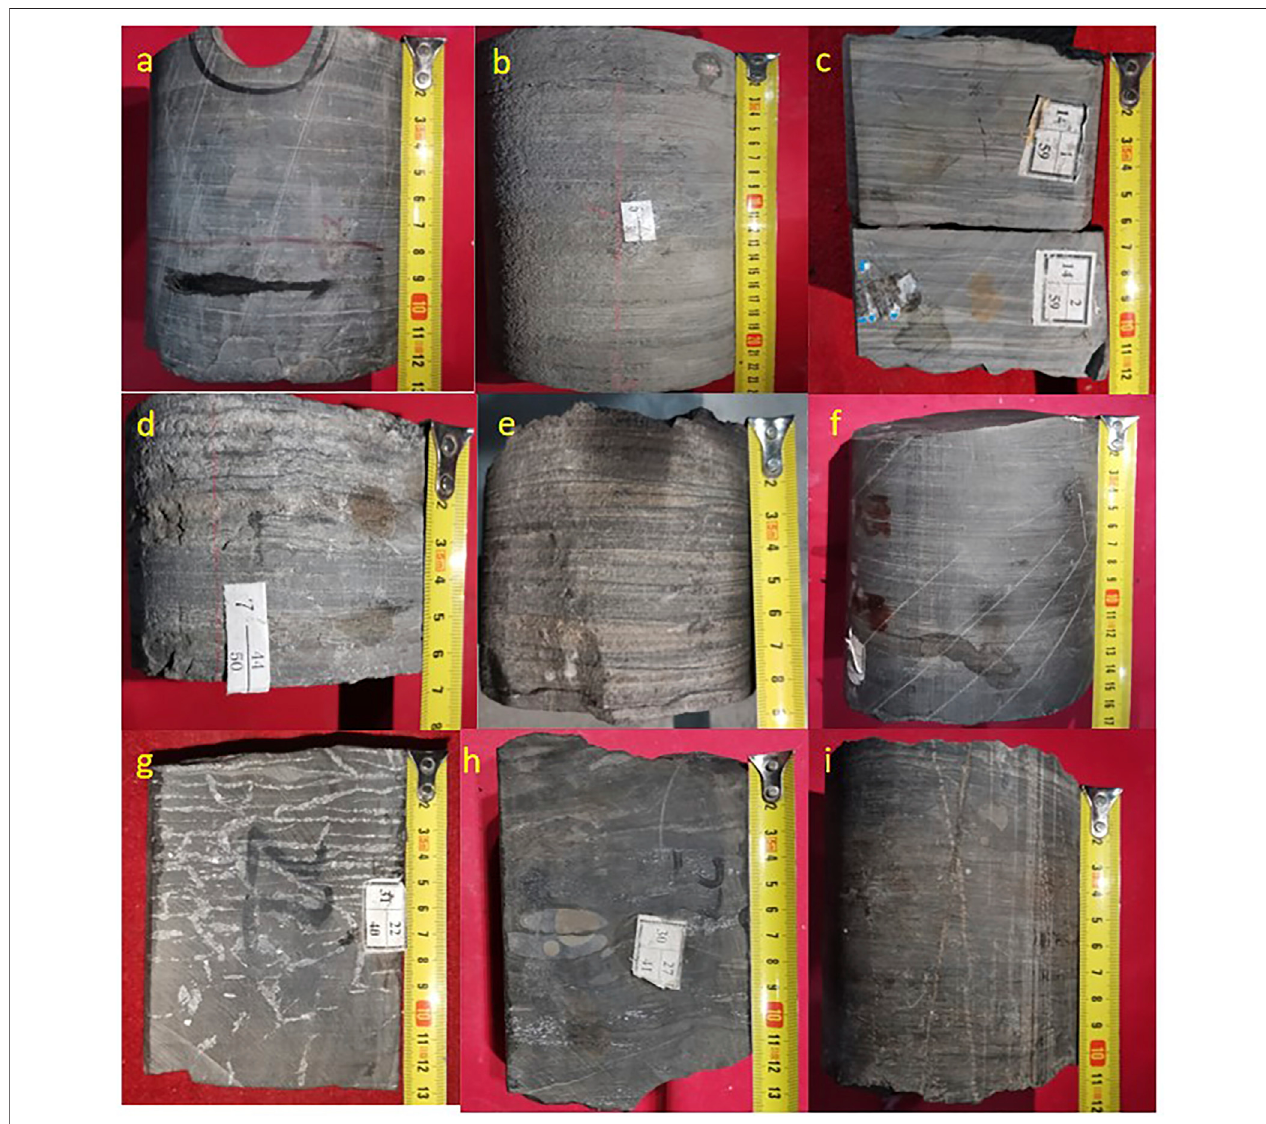
FIGURE2 | Core ofSix Types of Rocks inthe Lucaogou Formation ofthe Jimsar Sag. (A) 33/38 1st Barrel No. J251 Well, dark grey calcareous mudstone; (B) 26/ 50 5th Barrel No. J10024 Well, dark grey argillaceous dolomite; (C) 1, 2/59 14th Barrel No. J10025 Well, light grey argillaceous dolomite; (D) 44/50 7th Barrel No. J10024Well,darkgreymarlite; (E) 58/701stBarrelNo.J32Well,lightgreydolomiticsiltstone; (F) 15/355thBarrelNo.J305Well,greyblackdolomitemudstone; (G) 22/ 40 31st Barrel No. J10025 Well, grey black argillaceous siltstone; (H) 27/41 30th Barrel No. J10025, dark grey calcareous siltstone; (I) . 63/74 5th Barrel No. J251 Well, dark grey silty